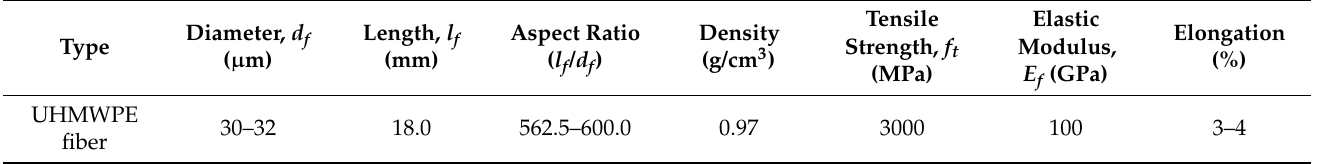
Table 3. Geometrical and physical properties of ultra-high-molecular-weight polyethylene (UHMWPE) fiber. Type Diameter, d f